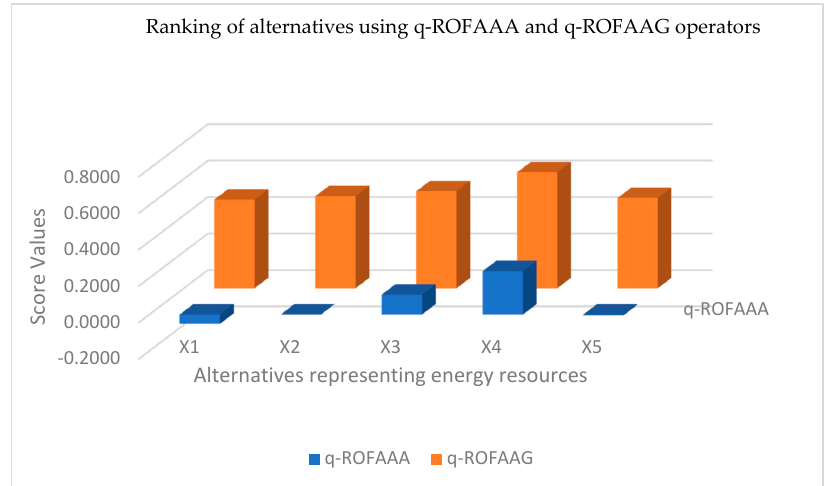
Figure 2 . Representation of ranking results using q-ROFAA operators . Figure 2. Representation of ranking results using q-ROFAA